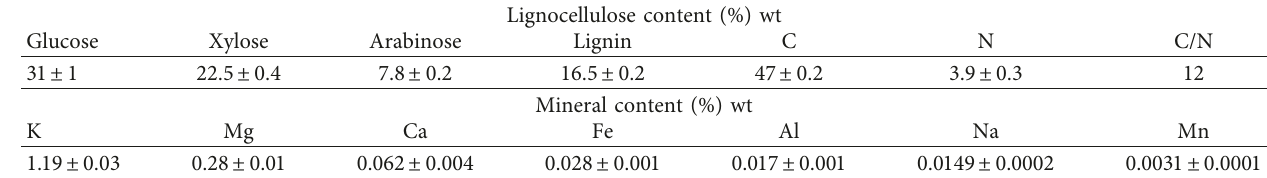
Table 1: Chemical composition of the corn cob employed.